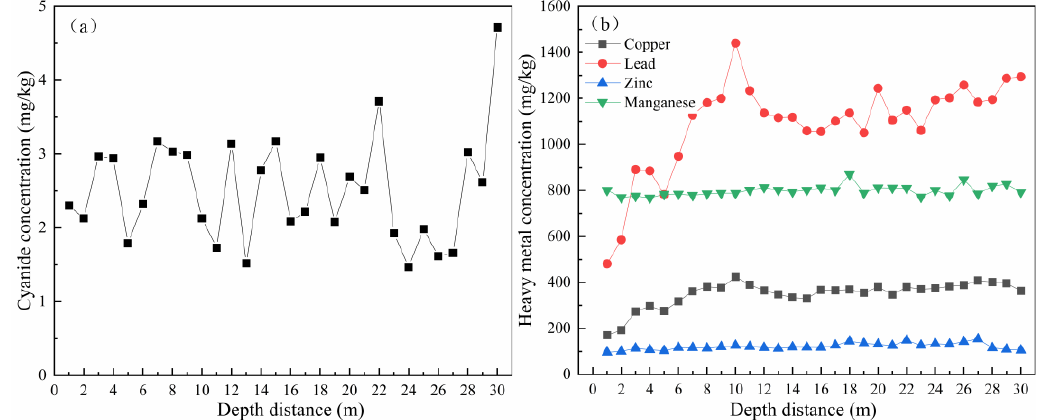
Figure 8. Vertical distribution of ( a ) cyanide and ( b ) heavy metal concentration in tailings pond.